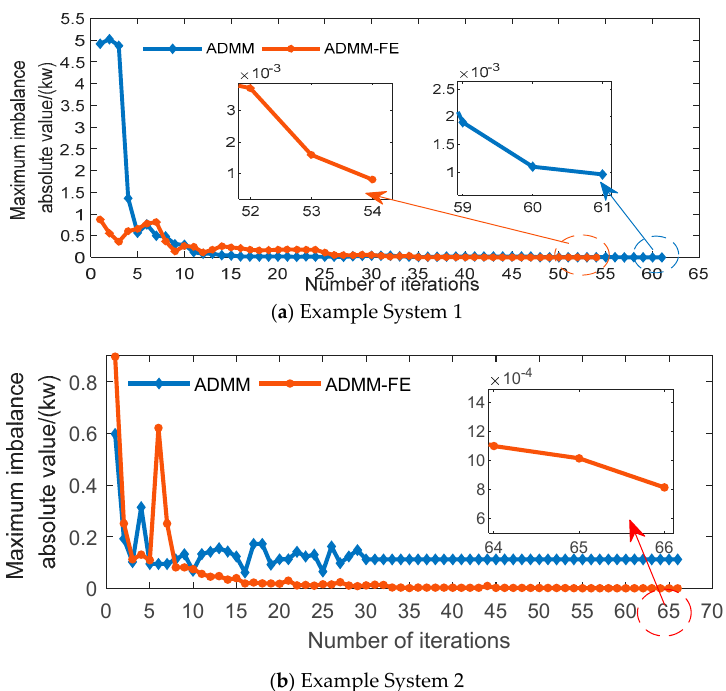
Appl. Sci. 2020 , 10 , 1214 Figure 2. The absolute maximum value of the unbalanced amount. Figure 2. The absolute maximum value of the unbalanced amount.